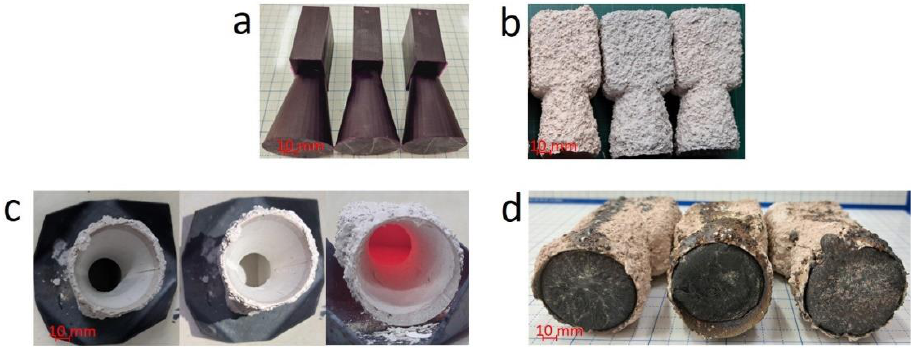
Figure 7. ( a ) 3D-printed part using the hollow design with a wall thickness of 0.8 mm. ( b ) Coated shell. ( c ) Shell mold. ( d ) Casted parts.